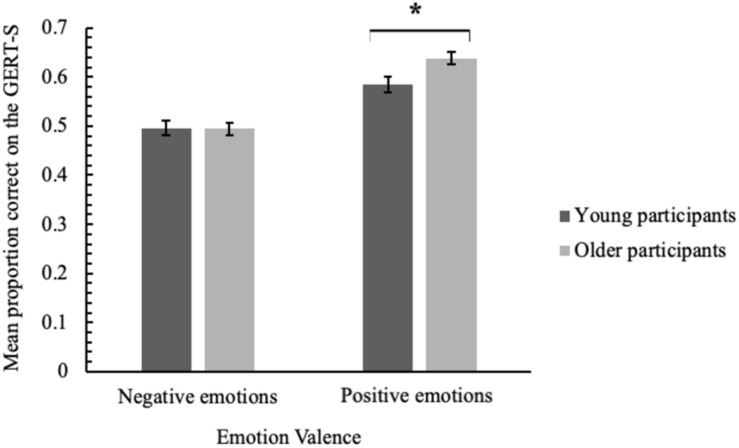
Mean proportion correct on the GERT-S for negative and positive emotions, as a function of participant age group. Error bars denote one standard error around the mean and the asterisk signifies a significant difference between participant age group means.